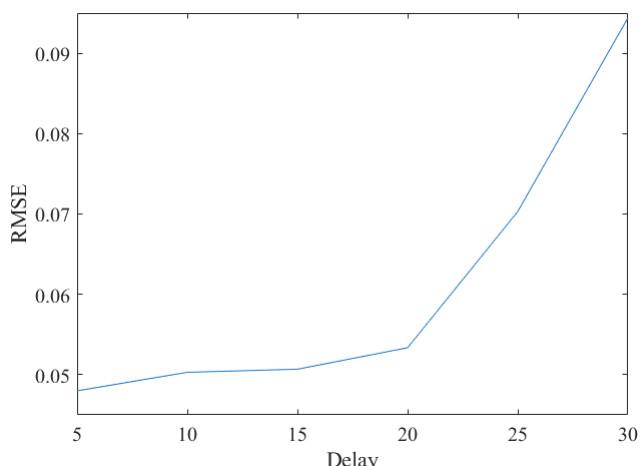
Figure 7. The relationship between the testing root-mean-square error (RMSE) and the time delay.